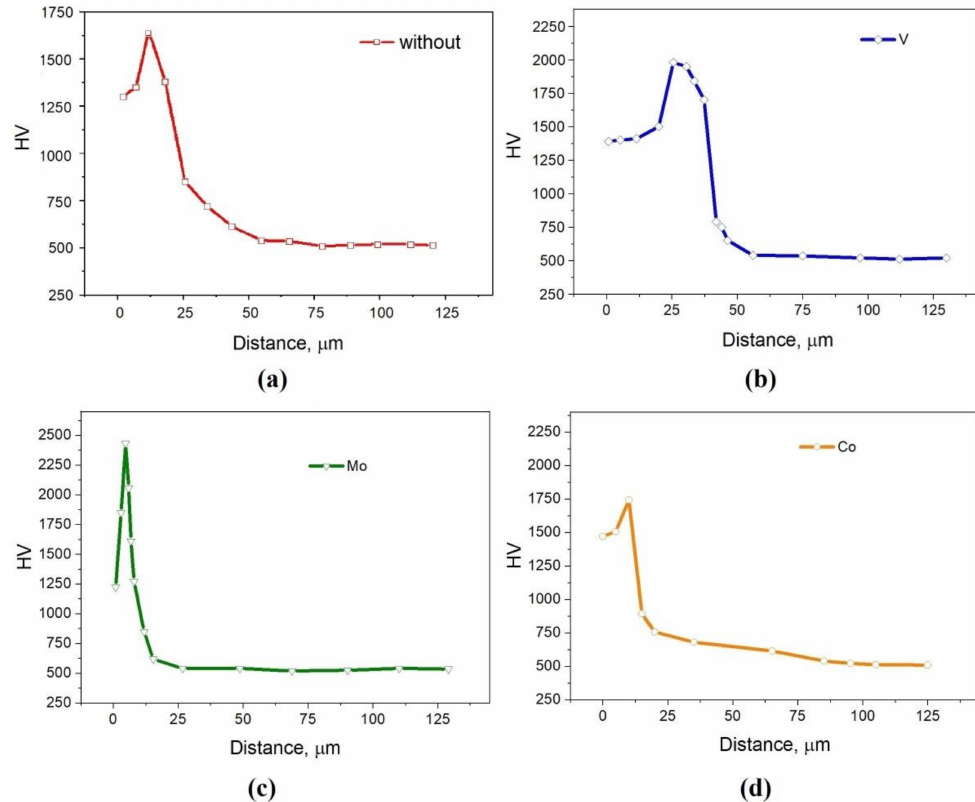
Figure 4. The microhardness values from the surface into the interior of the sample: ( a ) without additives; ( b ) with 5% FeV; ( c ) with 5% Mo; ( d ) with 5%